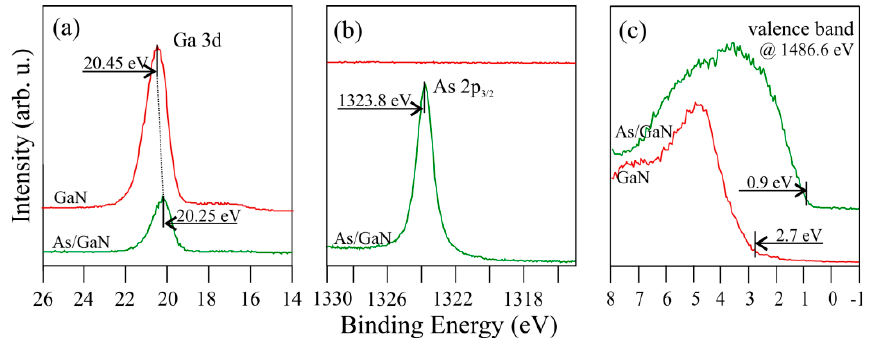
Figure 30. XPS spectra of ( a ) Ga ‐ 3d, ( b ) As ‐ 2p 3/2 , and ( c ) UPS spectra of the valence band for bare and As ‐ film ‐ covered GaN(0001). Mean film thickness is ~5 nm. Data previously published in [57].